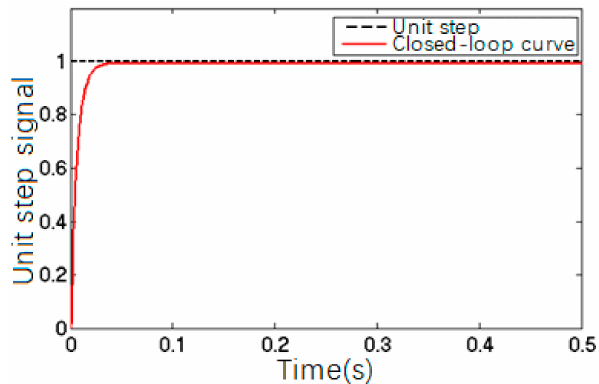
Figure 10. The simulation curve of the piezoelectric ceramic pressure closed-loop control.